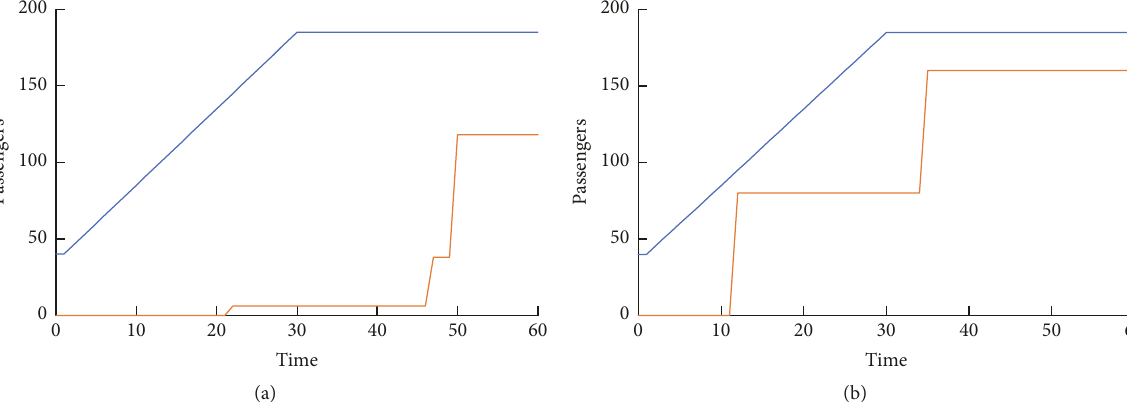
Figure 5: Comparing cumulative arrival departure curves of station 3 in upward direction before and after optimization in illustrative example.